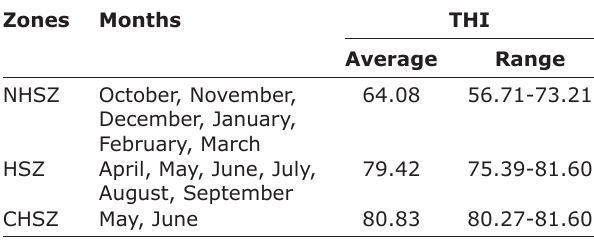
Table-3: Classification of zones based on THI values in buffalo [31].